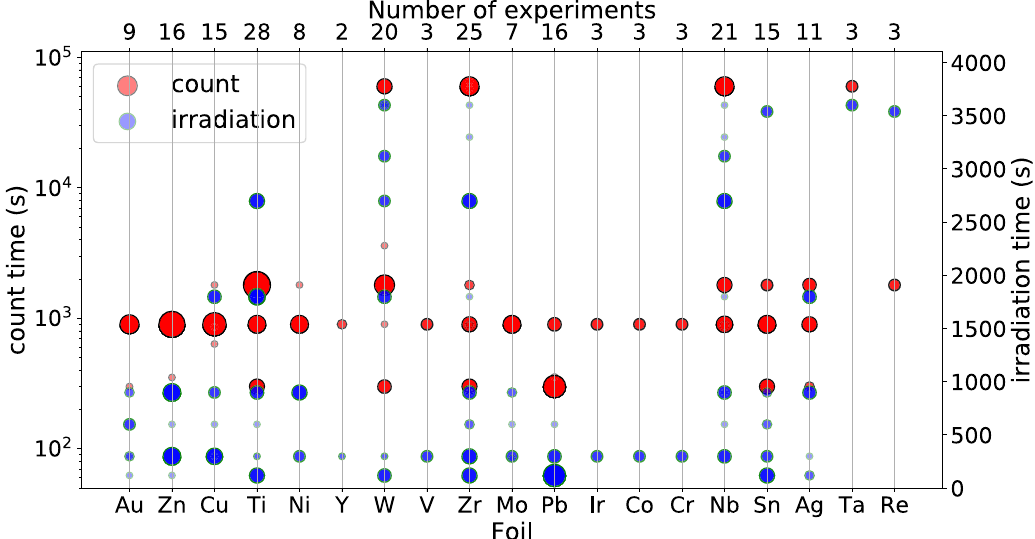
Figure 1: The foils used in experimental campaigns 2, 3, 4, and 5, with their corresponding irradiation (blue, right linear y-axis) and count (red, left logarithmic y-axis) times. The diameter of the point represents the number of repeated experiments (same foil and irradiation/cooling times). The full data set covers 211 experiments with individual foil experiment counts listed along the top x-axis. Reference foils are